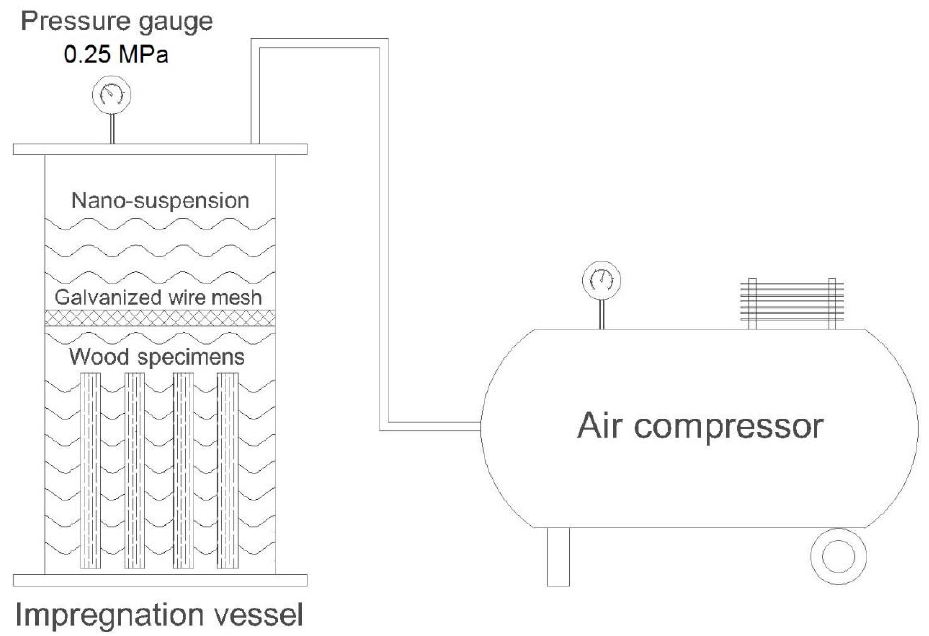
Figure 1. Laboratory scale pressure vessel for impregnating of specimens cut to size for different tests.